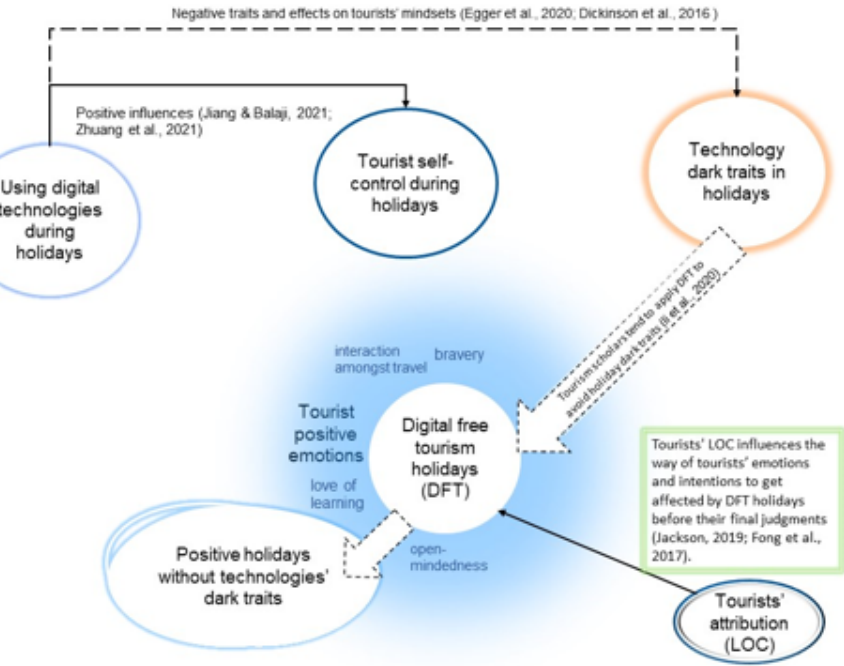
Figure 1. The interdependence between DFT, LOC, and tourists’ behavioral outcomes .